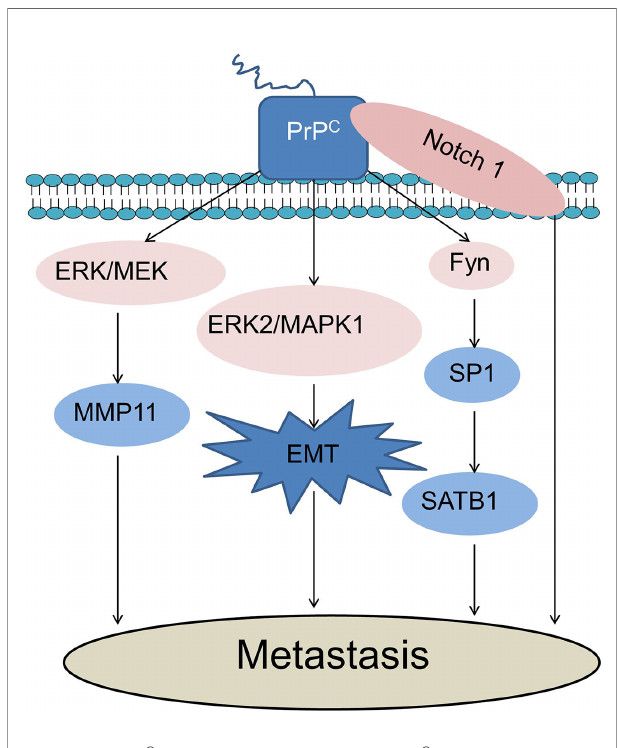
FIGURE 2 | PrP C promotes cancer cellmetastasis. PrP C could promote cancer cellmetastasis throughactivation of the MEK/ERK pathwayandconsequent transactivationofMMP11. PrP C promotes EMT throughthe activation of the ERK2/MAPK1 pathwayduring cancer metastasis. PrP C could promote tumor metastasisvia up-regulating the PrP C -Fyn-SP1-SATB1 axis. Notch1 and PrP C couldform an interaction networkto promote cancer cell metastasis. ERK, Extracellular-signal-regulatedkinase; MEK, Mitogen-activatedprotein kinases; MMP11, Matrix metalloproteinase-11; MAPK, Mitogen-activated proteinkinase; EMT, Epithelial-mesenchymal transition; SATB1, Special AT-rich sequence-binding proteins 1; SP1, Speci fi city protein